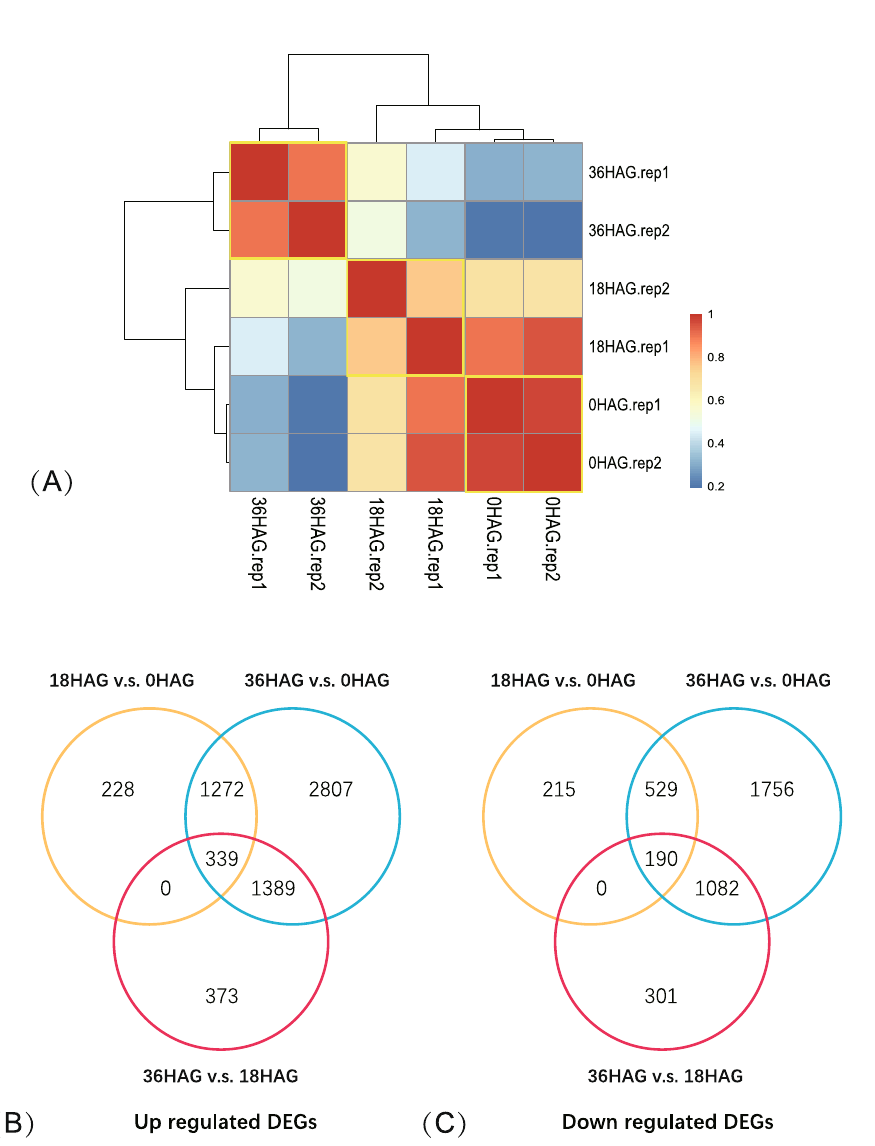
Figure 2. Pearson correlation coefficients between samples and DEGs identification. ( A ) Clustering of different samples based on Pearson correlation coefficients; ( B , C ) Venn map of up and down regulated DEGs respectively identified among different